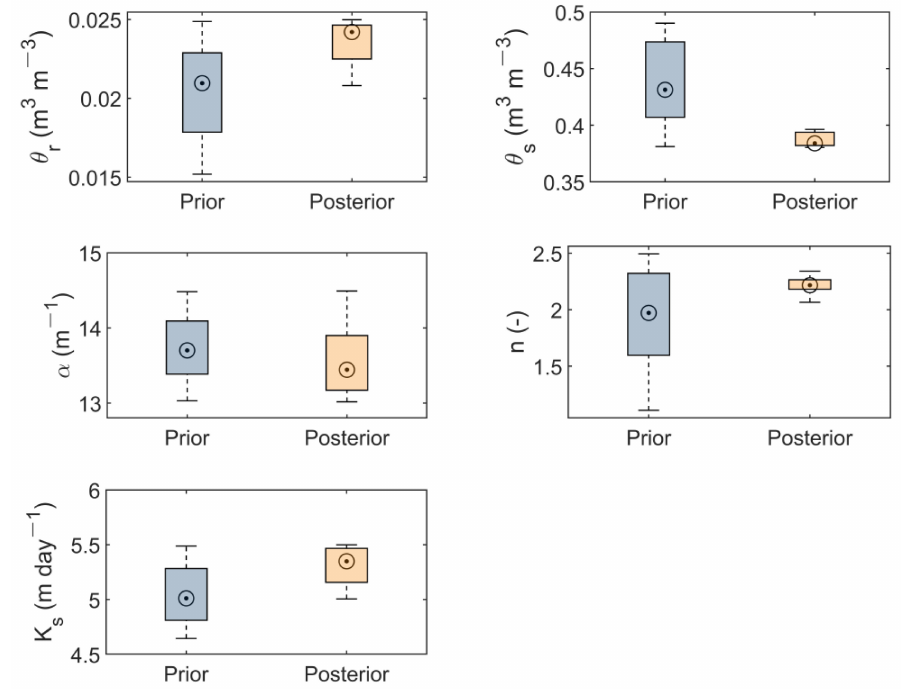
Figure 7. Comparison of the prior and posterior PDF of the parameters. Table 4. Mean values and standard deviations of the prior and posterior soil hydraulic parameters. Mean Value Standard Deviation Parameter